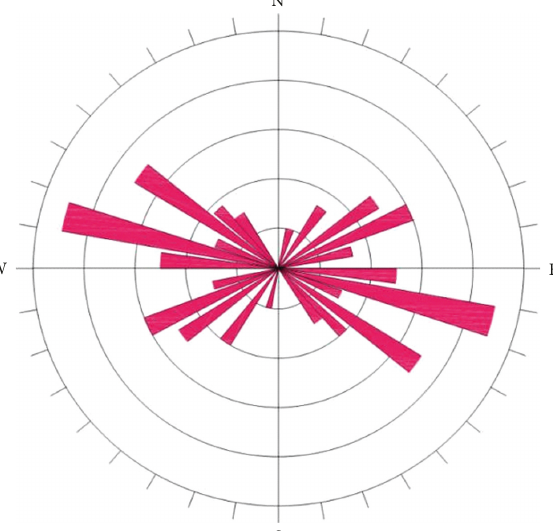
Figure 8: Distribution of maximum shear stress with depth and fitting curve.